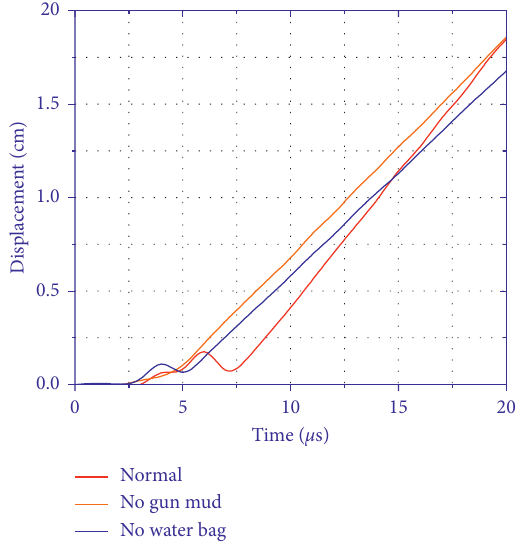
Figure 26: Maximum displacement curve comparison.